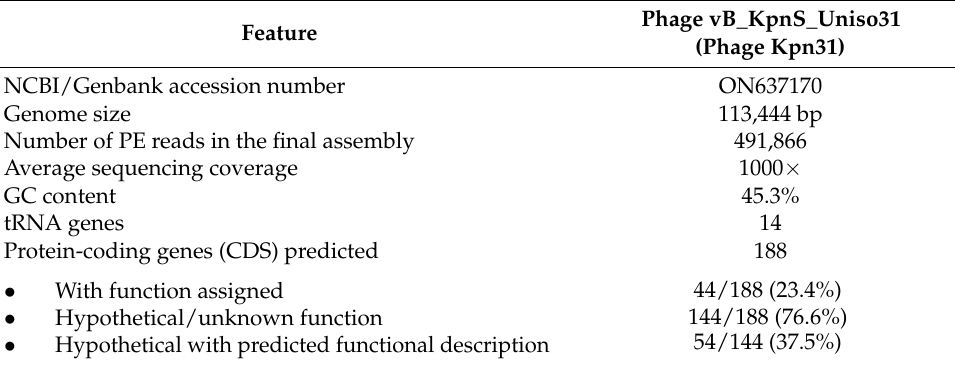
Table 1. Genomic features of the phage Kpn31